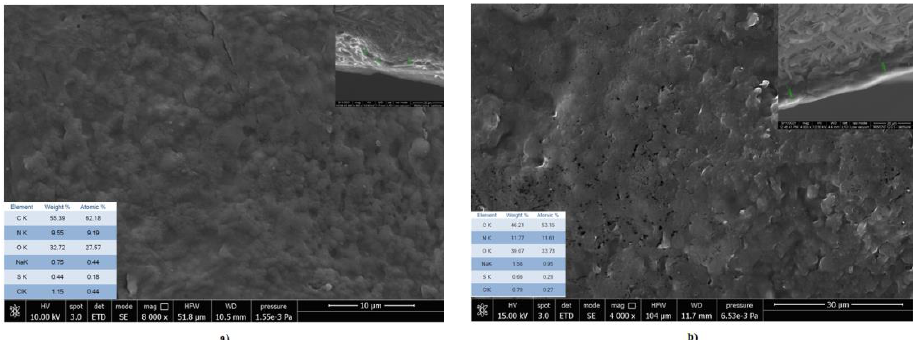
Figure 10. SEM images of ovine leathers ( a ) control and ( b ) MWCNT_O_0.5 for the surface with the inset images of cross sections and finishing layer measurement and elemental composition tables.